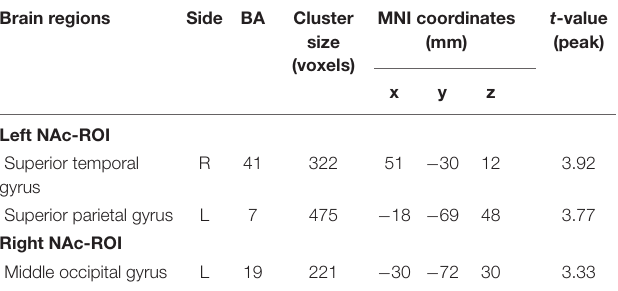
TABLE 2 | Group differences in functional connectivity of bilateral NAc-ROIs between EOS and HCs (EOS>HCs). Brain